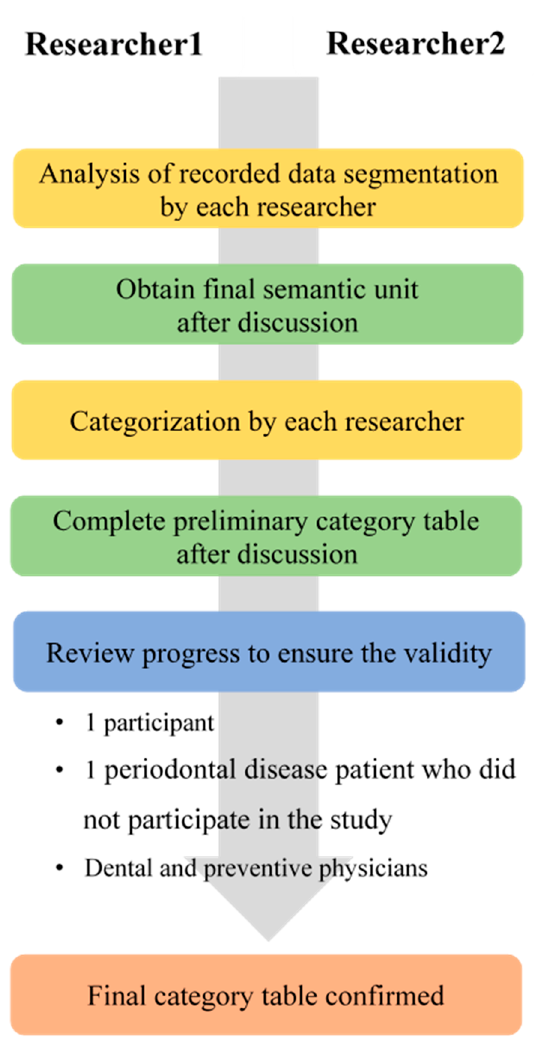
Figure 2. Analysis paradigm.